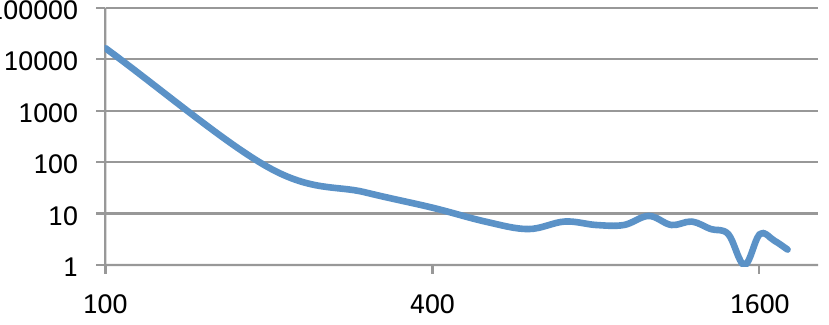
Figure 8. The sub-graph distribution of web-Stanford . The X -axis is the number of nodes, the Y -axis is the number of sub graphs containing that many nodes. It follows a power law distribution.